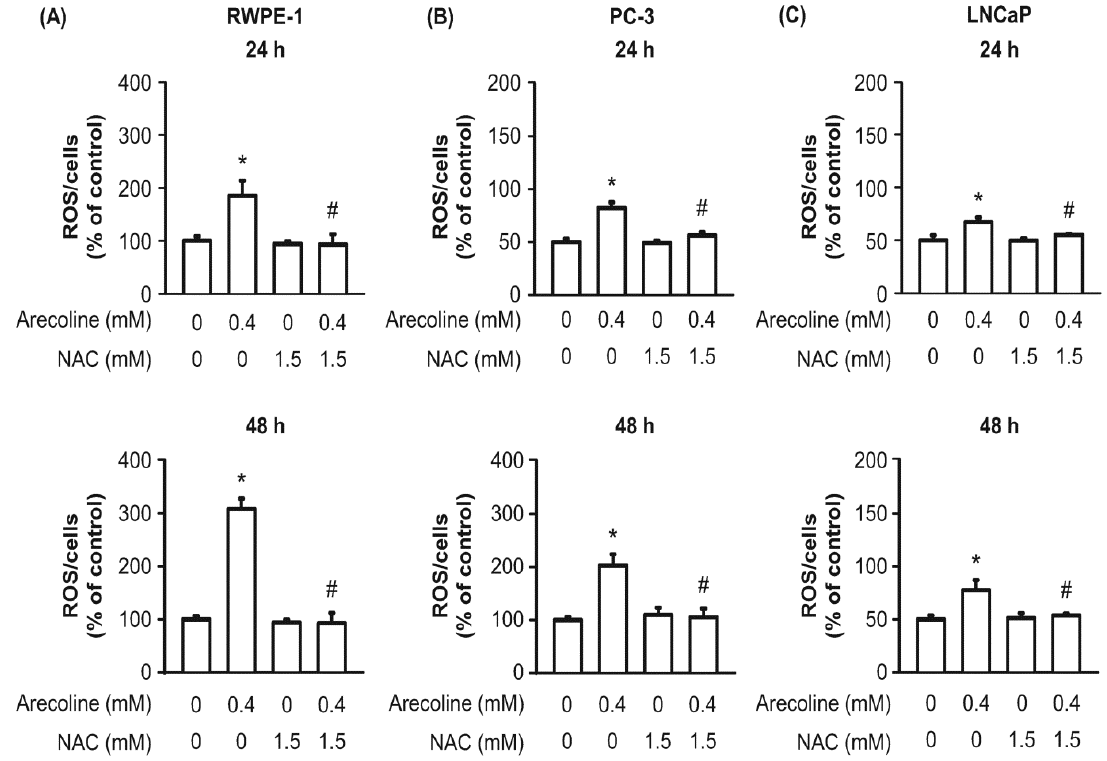
Figure 6. The effect of arecoline on the production of reactive oxygen species (ROS) was observed in normal RWPE-1 ( A ) and cancerous PC-3 ( B ) and LNCaP ( C ) prostate cells after 24 and 48 h of treatment. The induction of ROS production was reduced by pretreatment with N-acetylcysteine (NAC). Cells were pretreated with 1.5 mM NAC and then exposed to arecoline for 24 or 48 h. The ROS production was measured using the 2’,7’-dichlorofluorescein diacetate method. * p < 0.05 vs. the control; # p < 0.05 arecoline vs. arecoline + NAC.